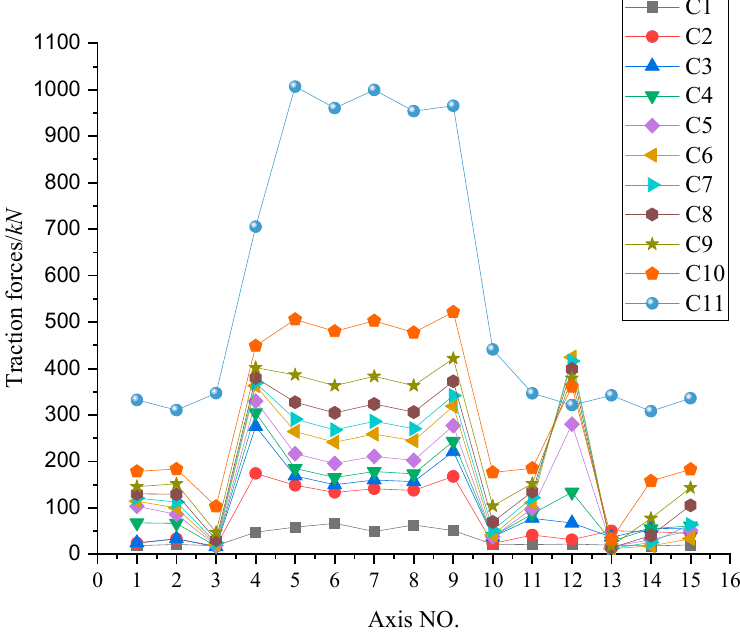
Figure 27. Variation curve of traction force during traction lifting.